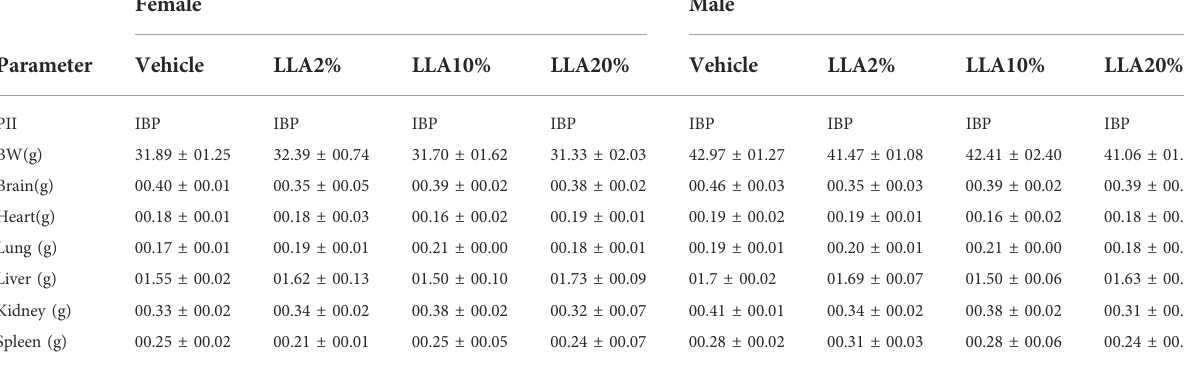
TABLE 3 PII, body, and organ weight of the mice topically treated with linalool + linalyl acetate combinations.